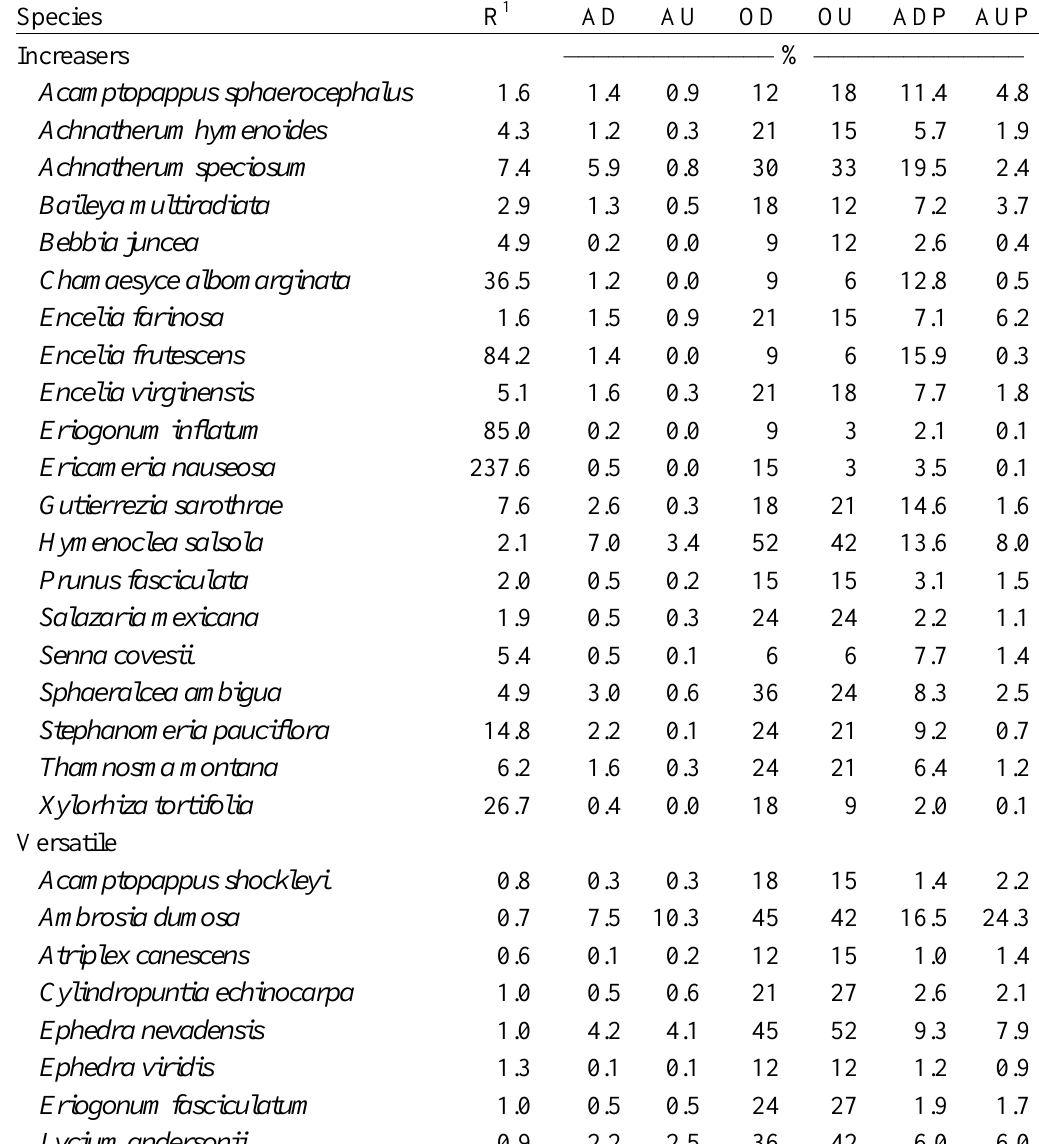
Table 4. Categorization of response to disturbance for major perennial species in the Mojave and Sonoran Deserts of the American